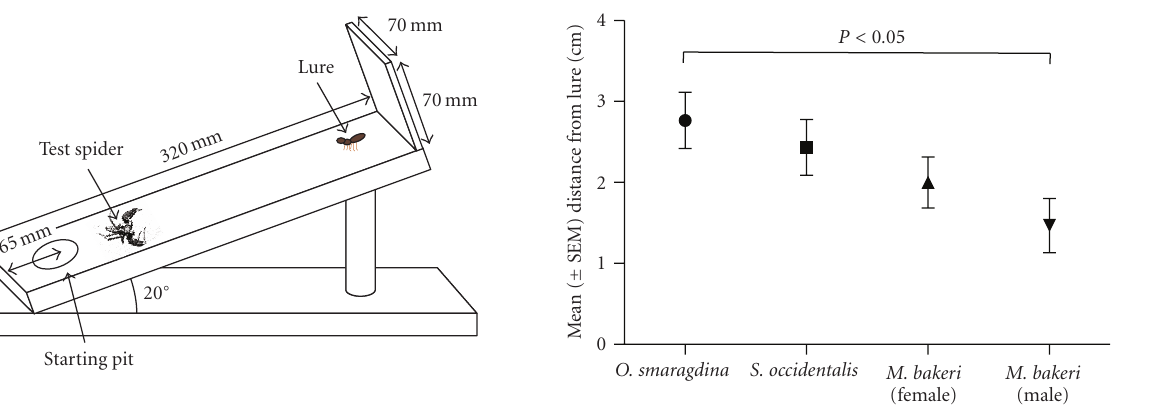
Figure 1: Ramp used for testing Portia fimbriata with lures of ants and ant mimics.